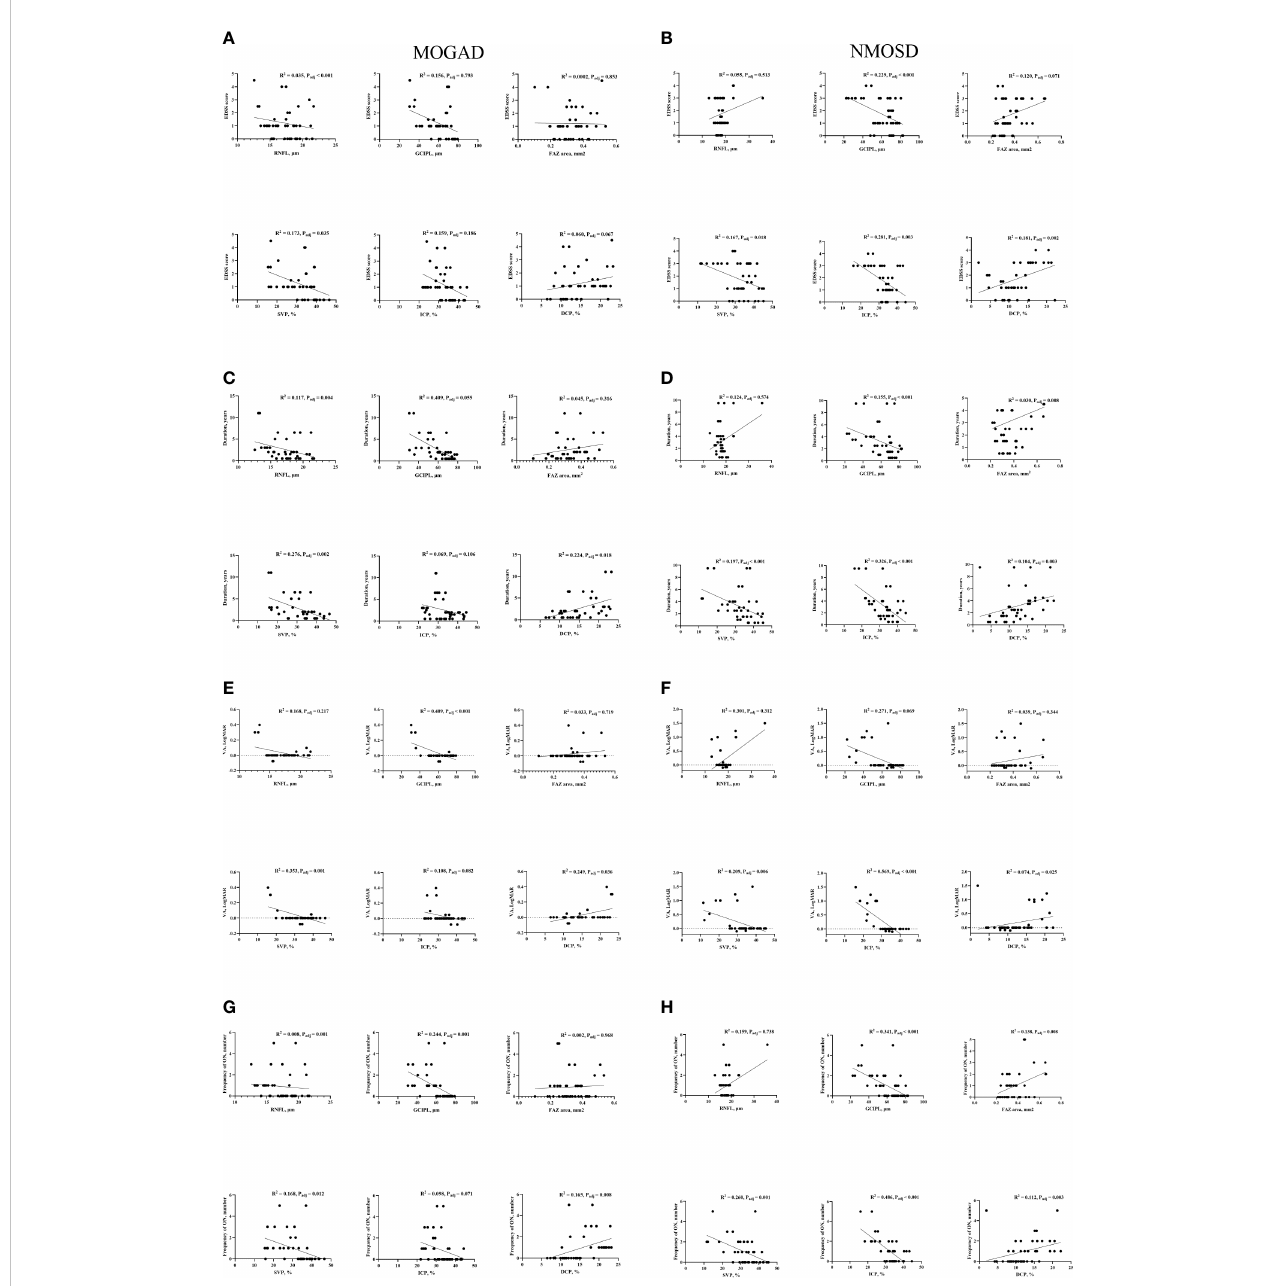
FIGURE 3 Correlation between clinical features and OCT/OCTA parameters in MOGAD and NMOSD patients. EDSS, Expanded Disability Status Scale; VA, visual acuity; FAZ, foveal avascular zone; SVP, super fi cial vascular plexus; ICP, intermediate capillary plexus; DCP, deep capillary plexus; RNFL, retinal nerve fi ber layer; GCIPL, ganglion cell, and inner plexiform layer; HC, healthy control; MOGAD, myelin oligodendrocyte glycoprotein antibody disease; NMOSD, neuromyelitis optica spectrum disorder. Association of retinal parameters and EDSS (A) , Duration (C) , VA (E) and Frequency of ON (G) in MOGAD patients. Association of retinal parameters and EDSS (B) , Duration (D) , VA (F) and Frequency of ON (H) in NMOSD